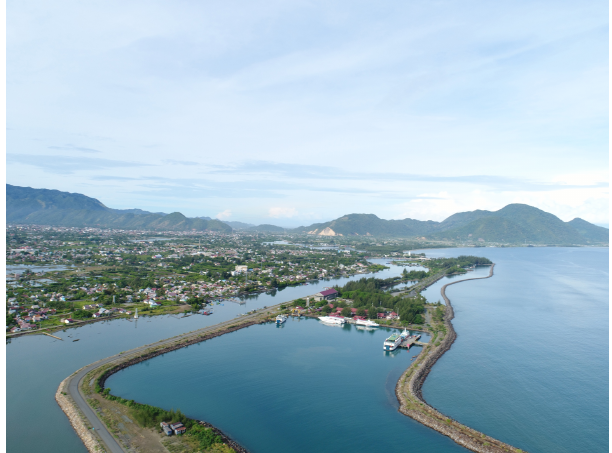
Figure 2. The situation of the coastal area of Banda Aceh based on an aerial image taken in February